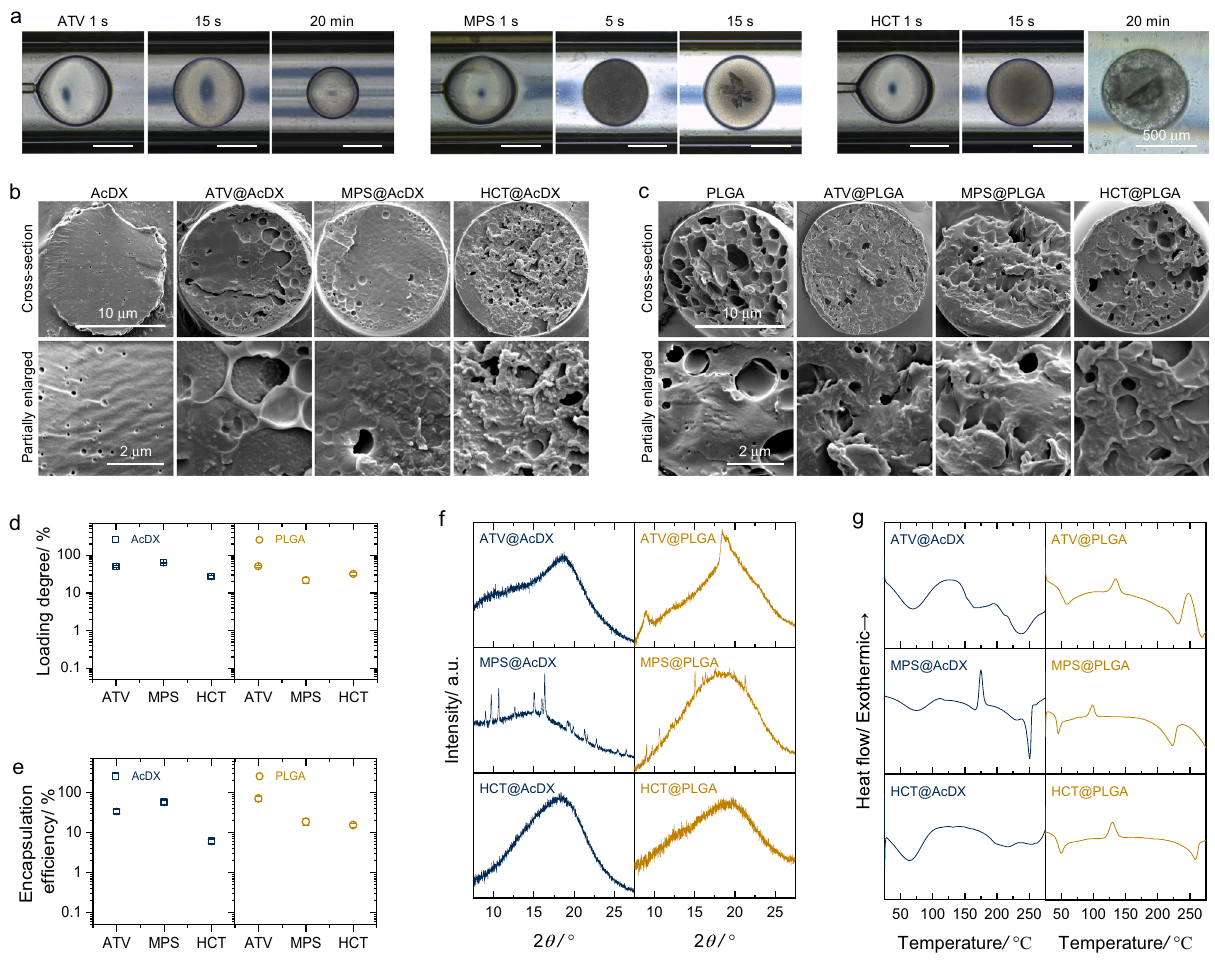
Fig. 2 The versatility of controlled in-droplet precipitation. a Light microscope images of drug precipitation process in the droplets generated by co- fl ow micro fl uidics. b , c Scanning electron microscope images of microspheres prepared by droplet micro fl uidics, using AcDX ( b ) and PLGA ( c ) as carrier matrix. d , e Drug loading degree ( d ) and encapsulation ef fi ciency ( e ) of microspheres prepared with and without dimethyl sulfoxide in the inner fl uid ( n = 3). Data are presented as mean values ± SD. f , g X-ray powder diffractogram ( f ) and differential scanning calorimetry curves ( g ) show the solid-state of the encapsulated drug molecules in